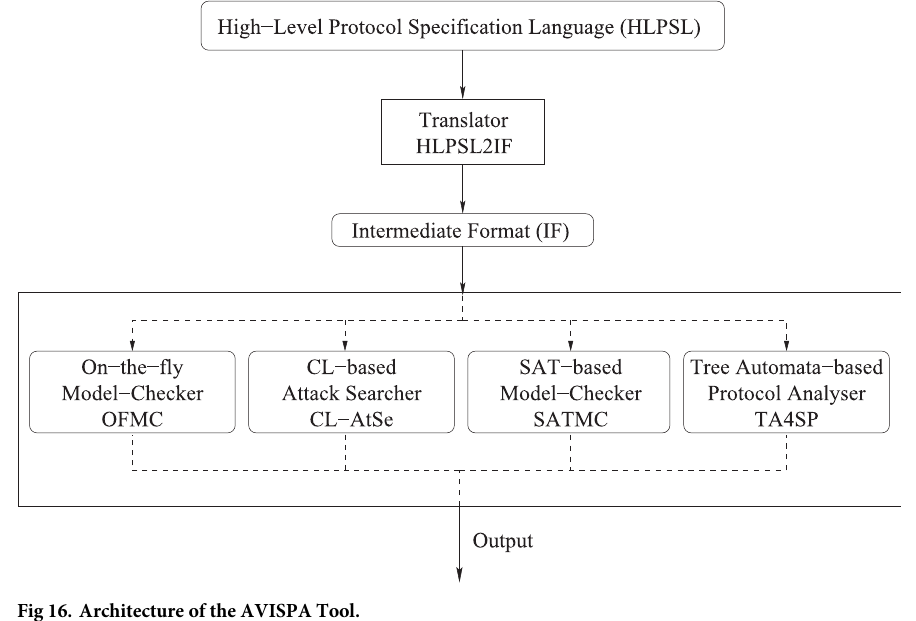
Fig 16. Architecture of the AVISPA